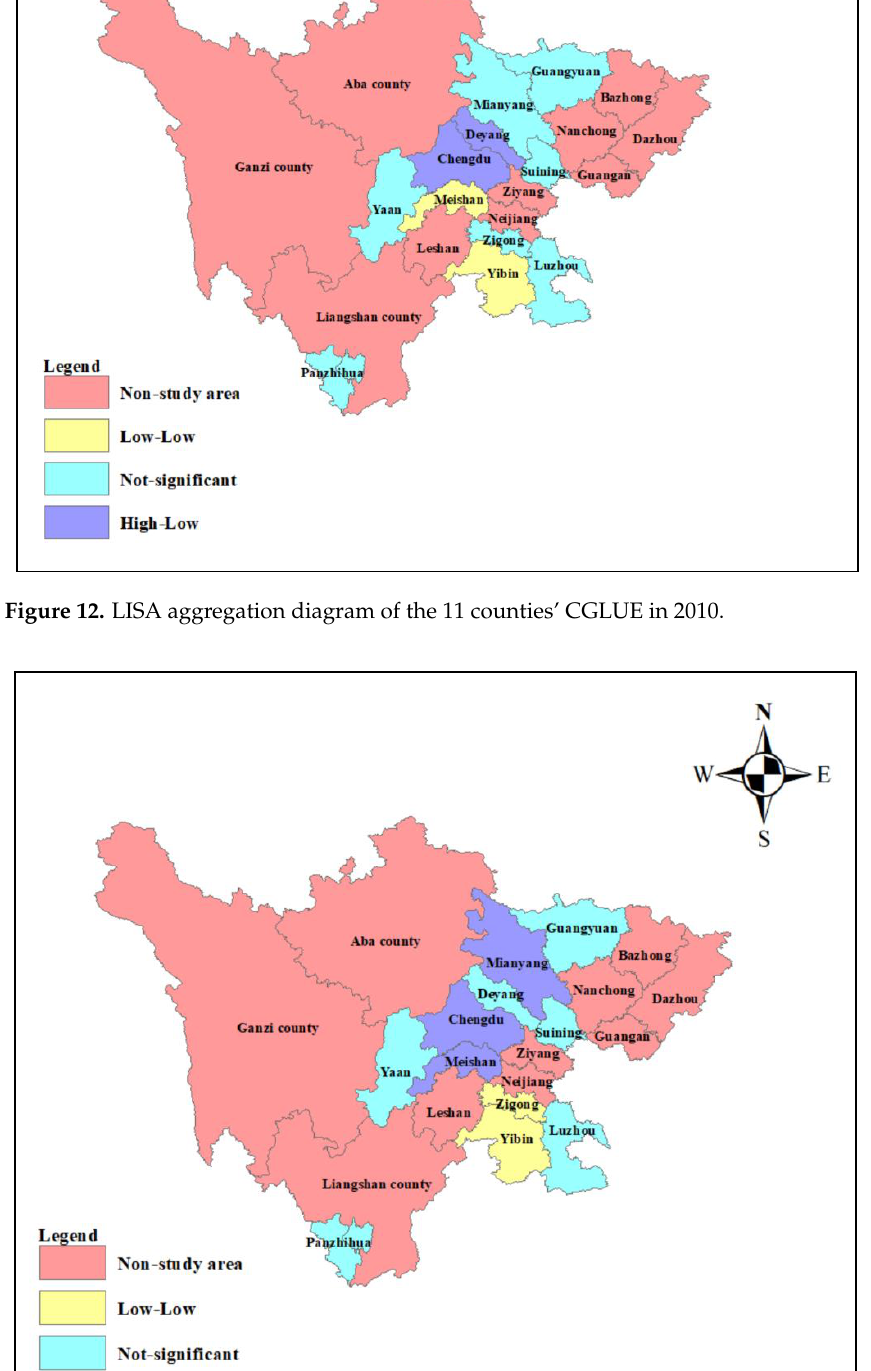
Figure 14. LISA aggregation diagram of the 11 counties’ CGLUE in 2020 .